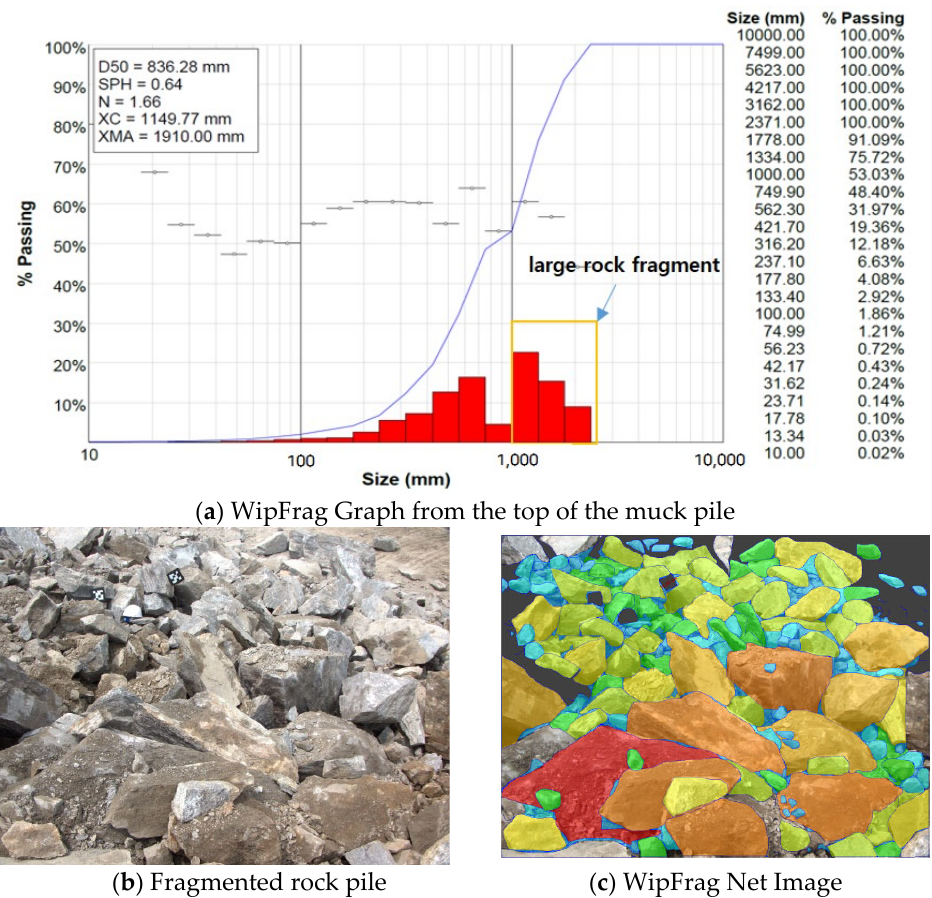
Figure 12. Rock pile image, contouring, histogram, and cumulative size curve of the fragmented block (bench top image of sand stemming case after blasting).